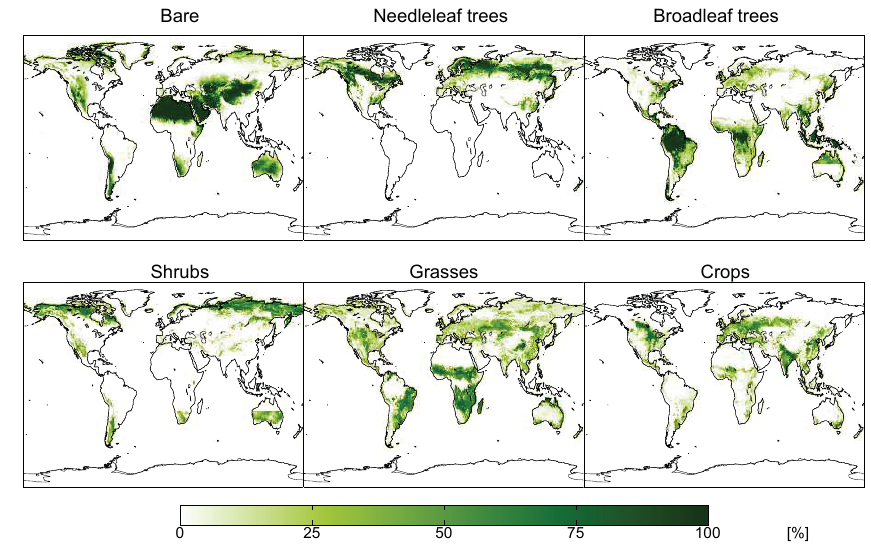
Figure 1. Present-day (year 2000) percentage of land area occupied by six classes of vegetation.